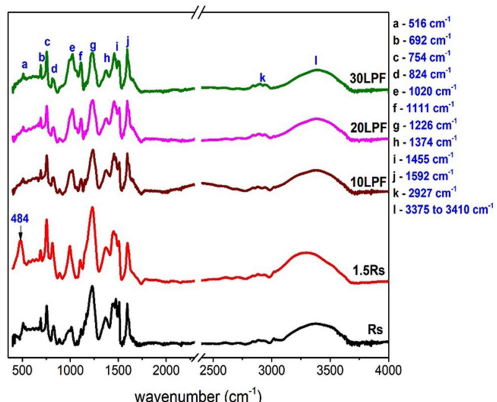
Figure 3. FTIR spectra of lignin-phenol-formaldehyde resins, equivalent unmodified resin and commercial resole product.